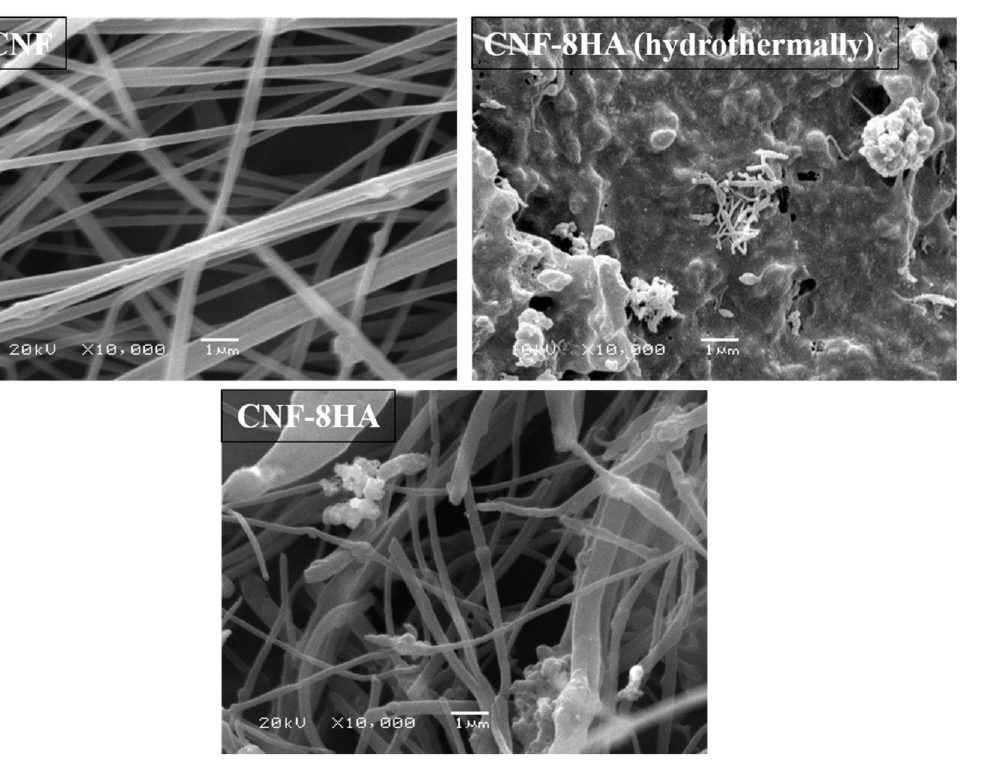
Figure 1. SEM images of the prepared CNF